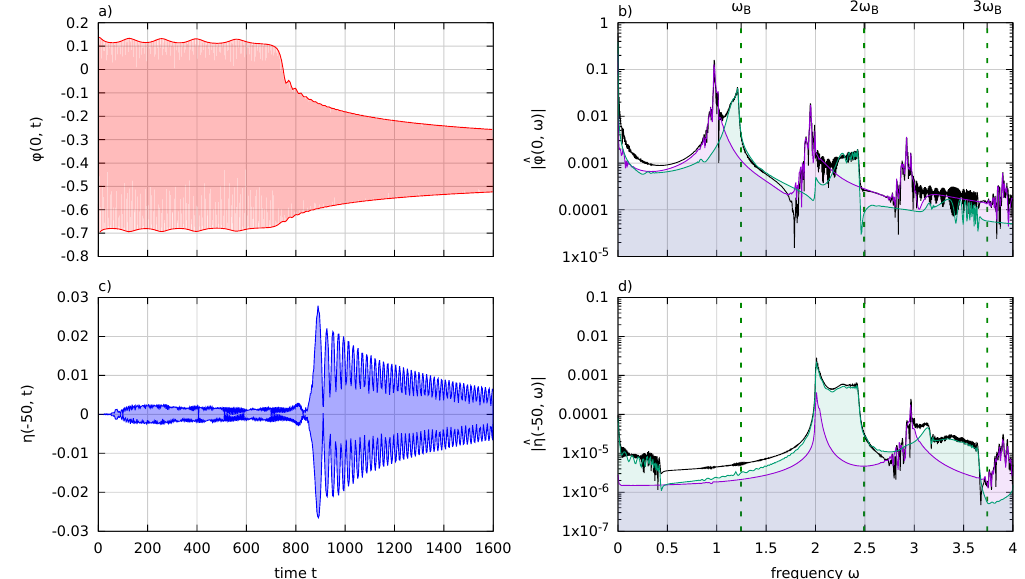
Figure 15 . Evolution of the boundary mode for H = 0 : 8393 < H 2 and large initial amplitude A 0 = 0 : 3. Plots a) and c) show the time evolution of the amplitudes of the boundary mode and radiation (cid:12)eld respectively, from the values of the (cid:12)eld at x = 0 and x = (cid:0) 50. Plots b) and d) show power spectra at the positions x = 0 and x = (cid:0) 50. The black lines show the power spectra from (cid:30) (0 ; t ) for times 0 < t < 1600 (plot b)) and (cid:30) ( (cid:0) 50 ; t ) for times 200 < t < 1600 (plot d)). The purple and green lines and (cid:12)lled areas show the power spectra for times before and after the transition (0 < t < 750 and 750 < t < 1600 for x = 0; 200 < t < 800 and 800 < t < 1600 for x = (cid:0) 50). rather slow, after some time there will be a sudden increase of the radiation (cid:13)ux and a switch to a much faster decay